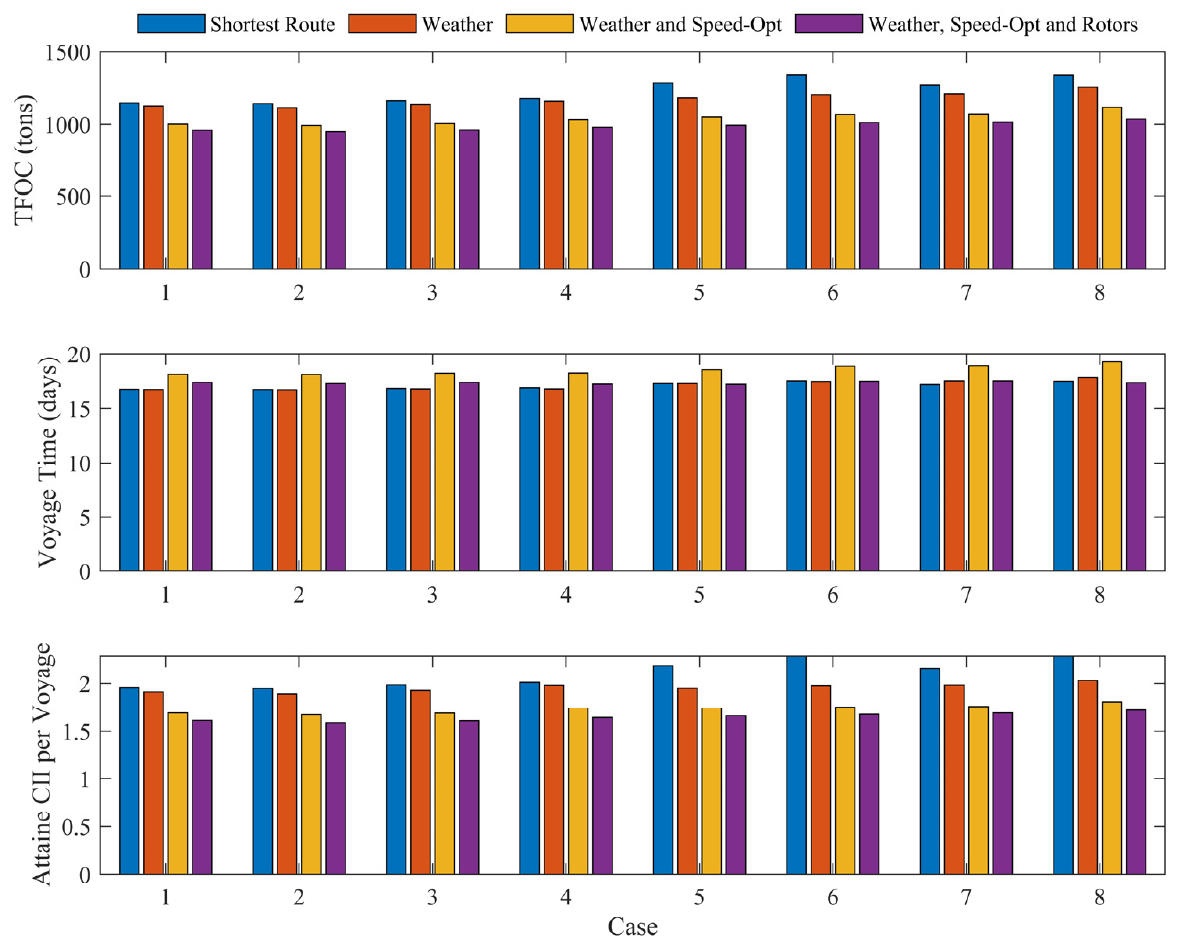
Figure 17. Results of TFOC, voyage time and the attained CII for different cases.